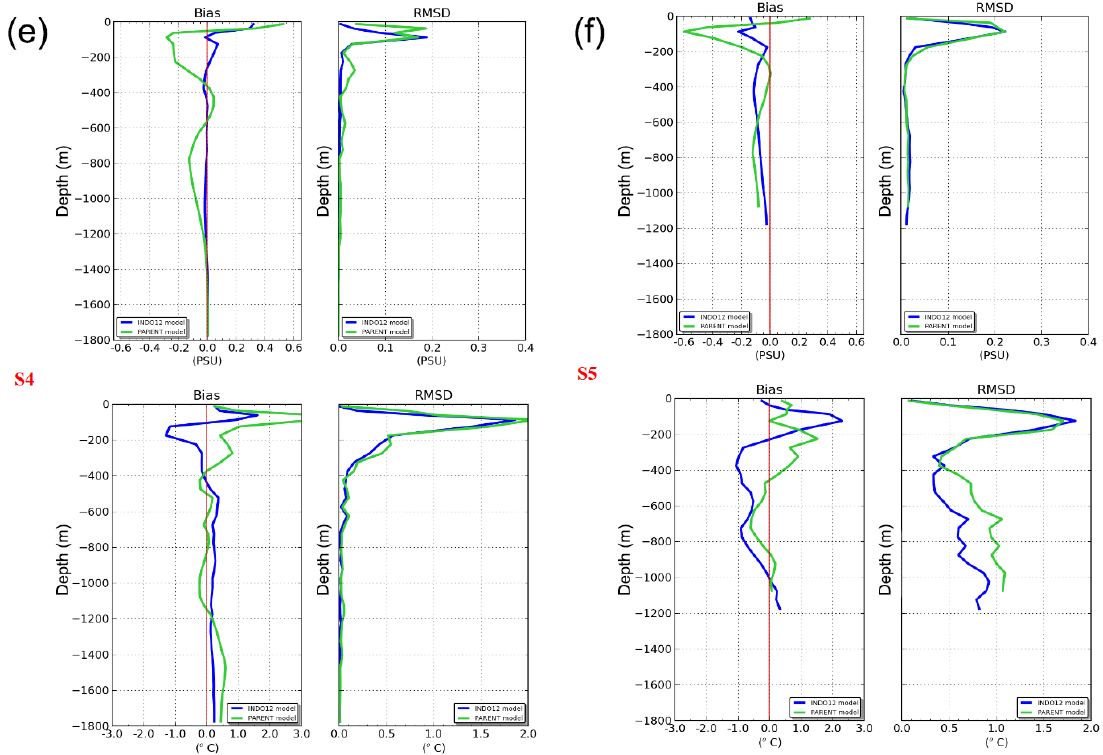
Figure 21. Bias and RMSD of salinity (up) and temperature (bottom) between INDOMIX data and INDO12 (blue line) and parent model PSY3 (green line) at at all mooring locations. Data are binned in 25m depth intervals for the first 100m depth and in 50m depth interval for deeper